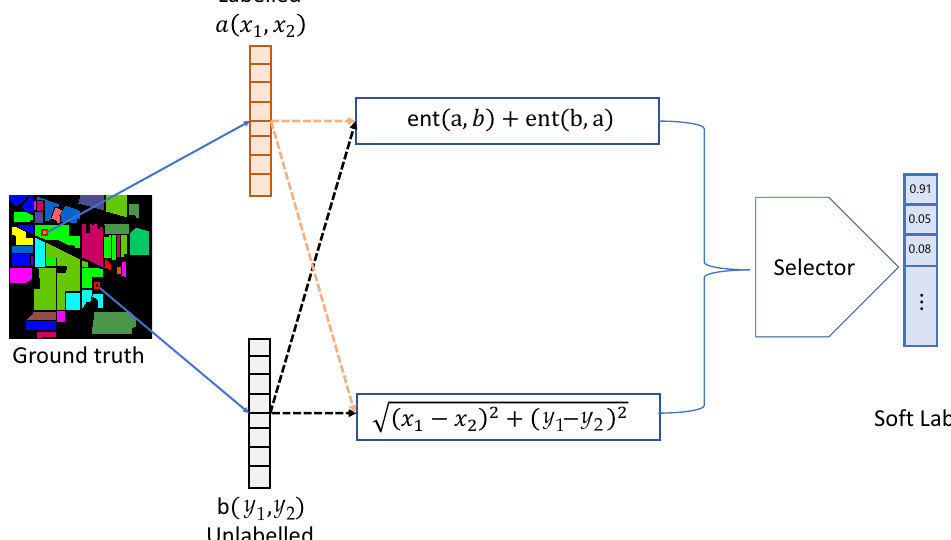
Figure 3. Soft Label Generation. The figure shows a, b are the HSI data corresponding to the ground truth image, and ( x 1 , x 2 ) , ( y 1 , y 2 ) denote the position coordinates of a, b, respectively. The ent is shorthand for entropy and the details of the Selector are shown in Equations